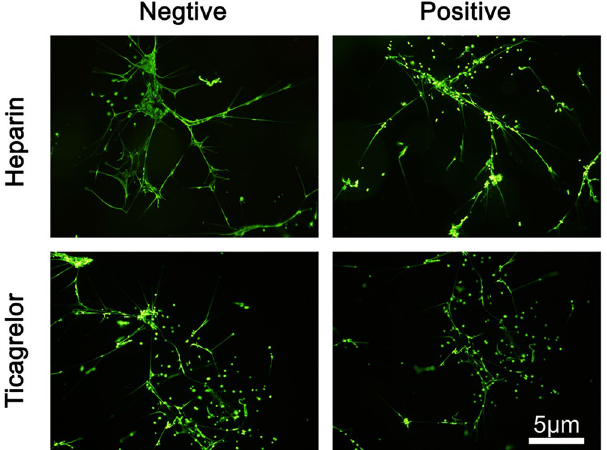
Figure 2. NETs in infarct-related coronary arteries were not sensitive to drugs, such as heparin or ticagrelor. Using heparin or ticagrelor treatment, do not reduced the proportion of NETs accumulating in infarct-related arteries. One representative out of 10 (Fig. 3) independent experiments is shown. Original magnification: A × 400, scale bar in C, 5 μ m. Green: NETs.